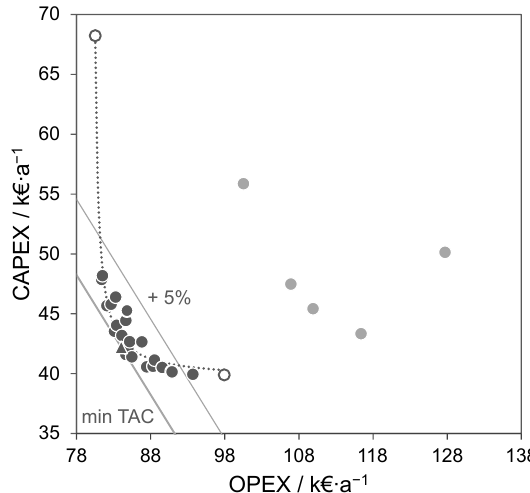
Figure A2. Set of solutions close to Pareto-optimality for the heteroazeotropic distillation of 1,4-dioxane and water using benzene as solvent. The white circles indicate the individual optimization of the OPEX and CAPEX, respectively, and the thick and thin lines are lines of constant TAC for the lowest costs and an additional 5%. The light-gray circles denote local optimal solutions, which are not in close vicinity to the approximated Pareto front and omitted for the fit of Equation (2) shown as a dotted